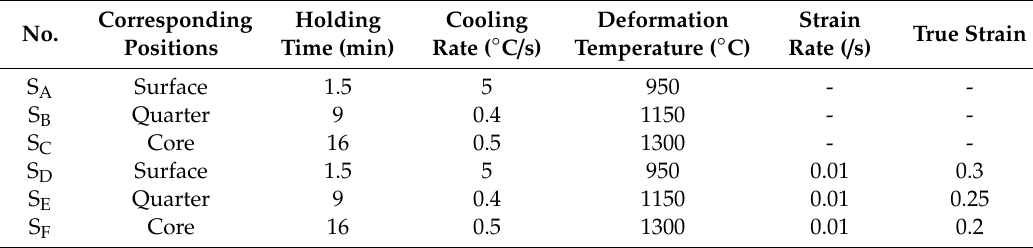
Figure 13. Experimental plan corresponding to the temperature history of the HHR 2 process. Table 3. Temperature evolution and deformation conditions of the specimens.